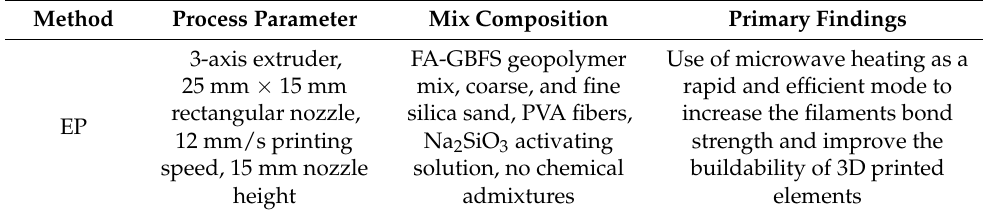
Table 4. Details of [87] research